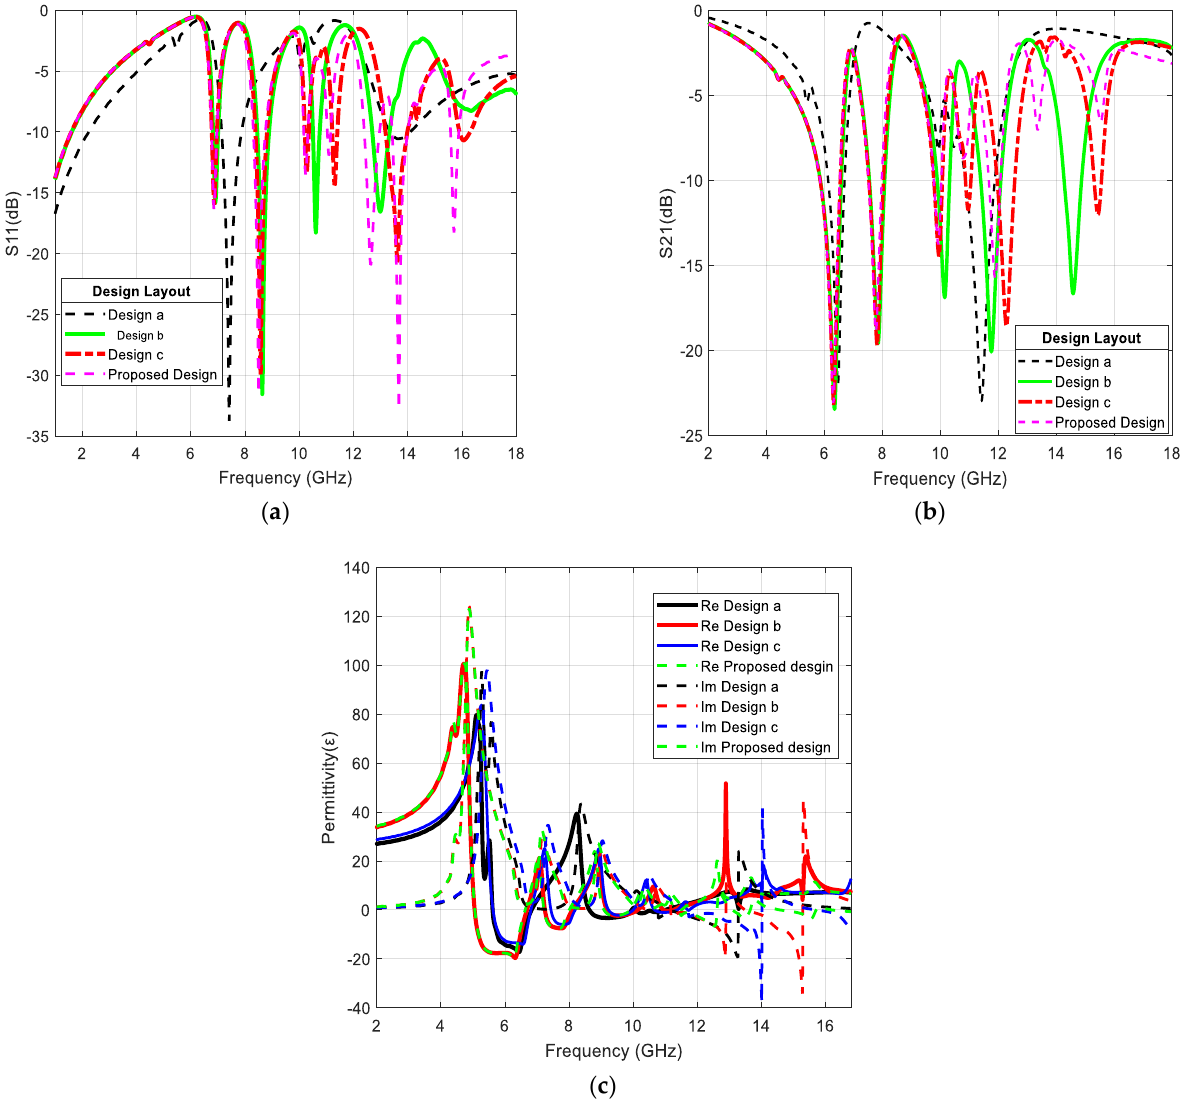
Figure 4. Reflection and transmission parameters of various configurations: ( a ) S 11 ; ( b ) S 21 , ( c ) per- mittivity. Table 2. Parameters of various design steps.